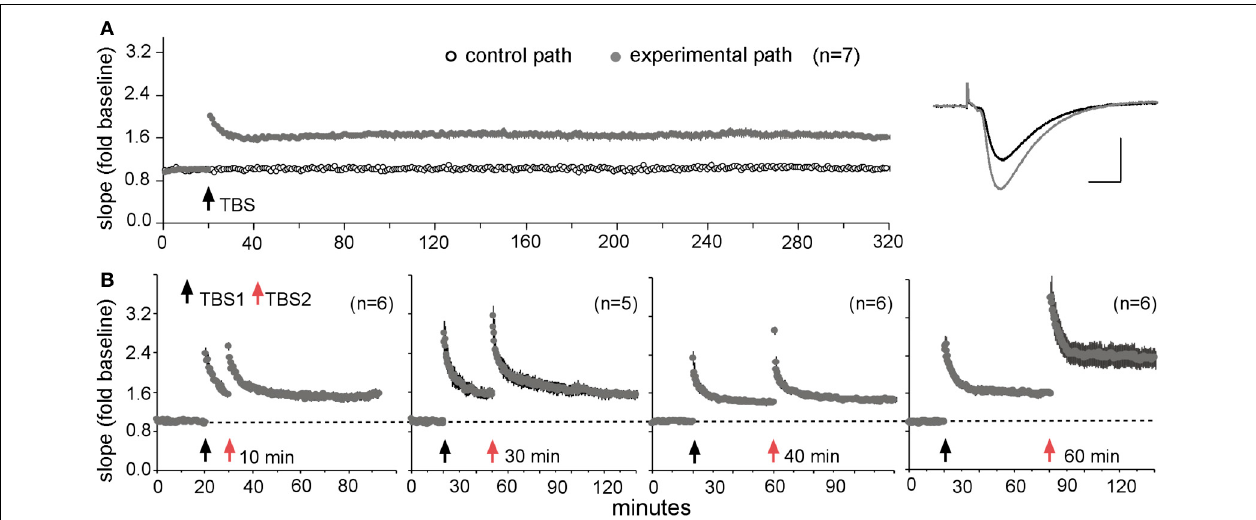
FIGURE 5 | A “spaced trials effect” for LTP. (A) Theta burst stimulation (TBS) produces stable LTP. A single train of ten bursts was delivered to one input to the CA1b recording field after 20min of collecting baseline synaptic responses to 3/min stimulation pulses in adult rat hippocampal slices. A second input to the same dendritic region received 3/min pulses throughout the session. Note that the potentiation of the experimental input did not